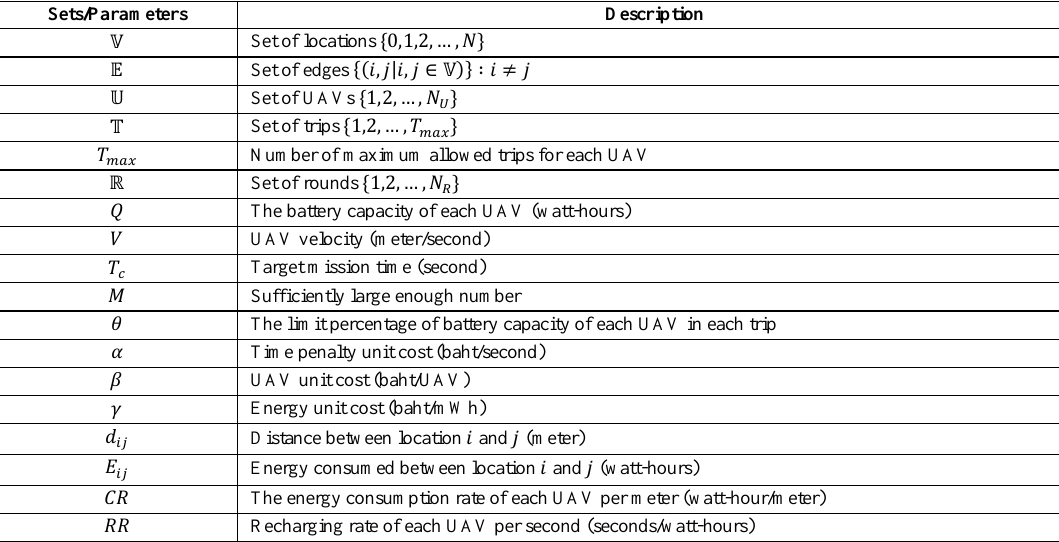
Table 1. Sets and